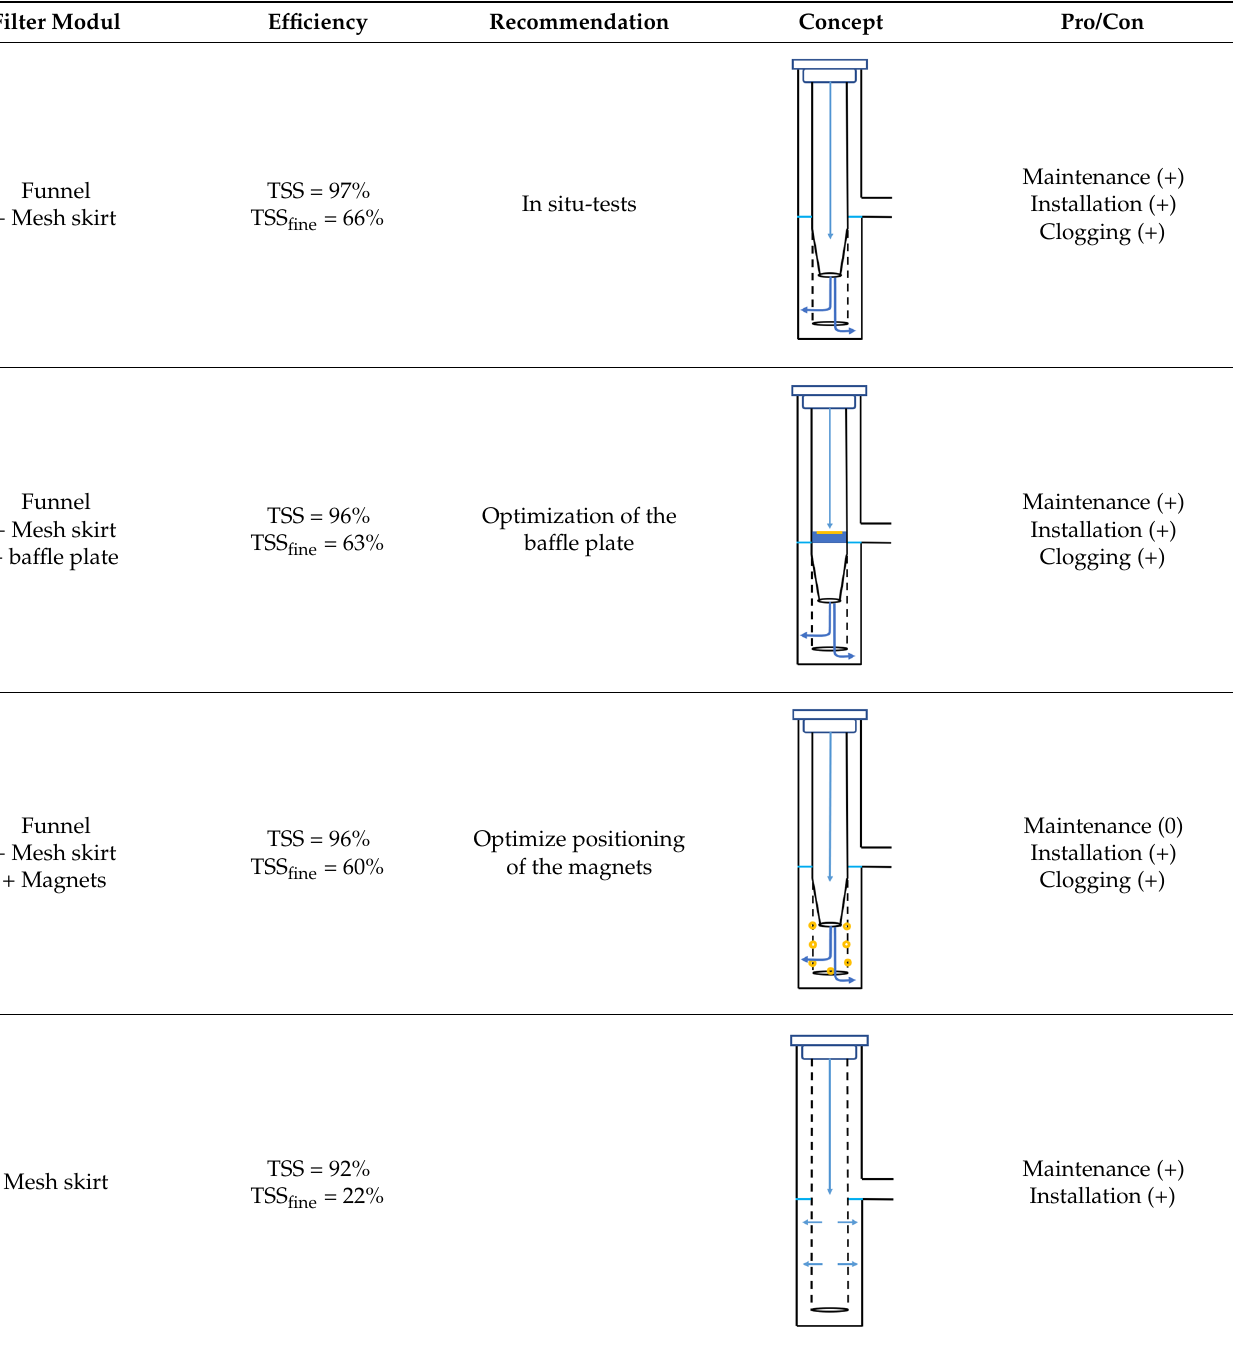
Table 9. Overview and evaluation of the tested filter modules.